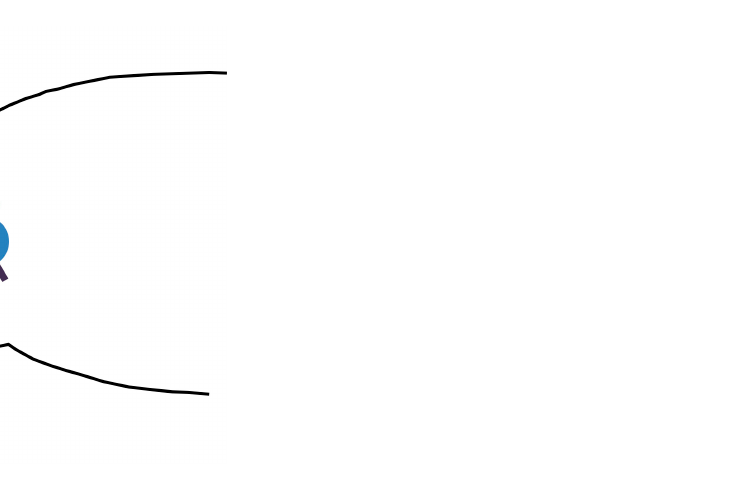
Figure 3. Cross sectional view of the magnetopause is shown (black line) between an MQN (blue circle) with magnetic moment (purple vector) at an angle of 60° to the velocity of the plasma (yellow arrows) flowing into the rest frame of the MQN. The plasma flow produces a net force (red arrow) centered at the top of the MQN and a corresponding torque vector into the page. The magnetopause is the locus of points at which the plasma pressure (on the left in Figure 3) is balanced by the magnetic pressure of the compressed magnetic field on the right. The complex shape of the magnetopause and resulting torque have been computed by Papagiannis [43] for Earth, illustrated in Figure 3, and extended to the case of MQNs. The effect can be understood by considering that the mean distance between the magnetopause and the MQN on the top half of Figure 3 is less than on the bottom half, which means that the magnetic field is compressed more on the top than on the bottom. Since force is transmitted by the compressed magnetic field, the net force is a push on the top, as shown by the red arrow.